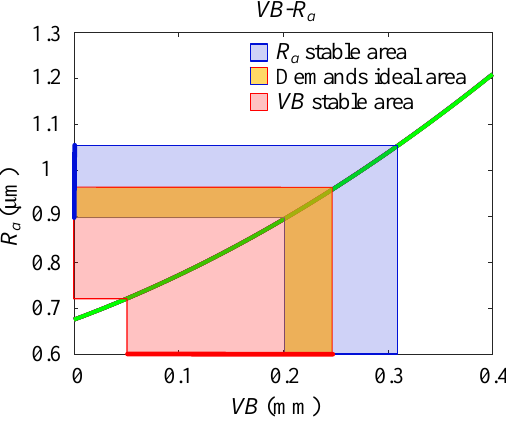
Figure 1. Relationship between wear and surface roughness.